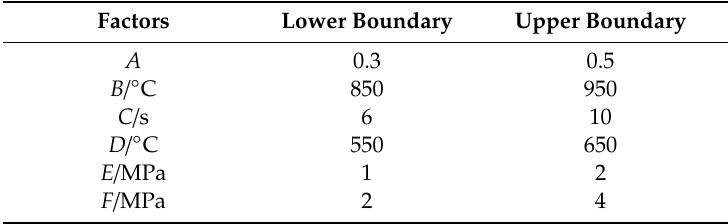
Table 3. Experimental factors and range of the optimal Latin hypercube.